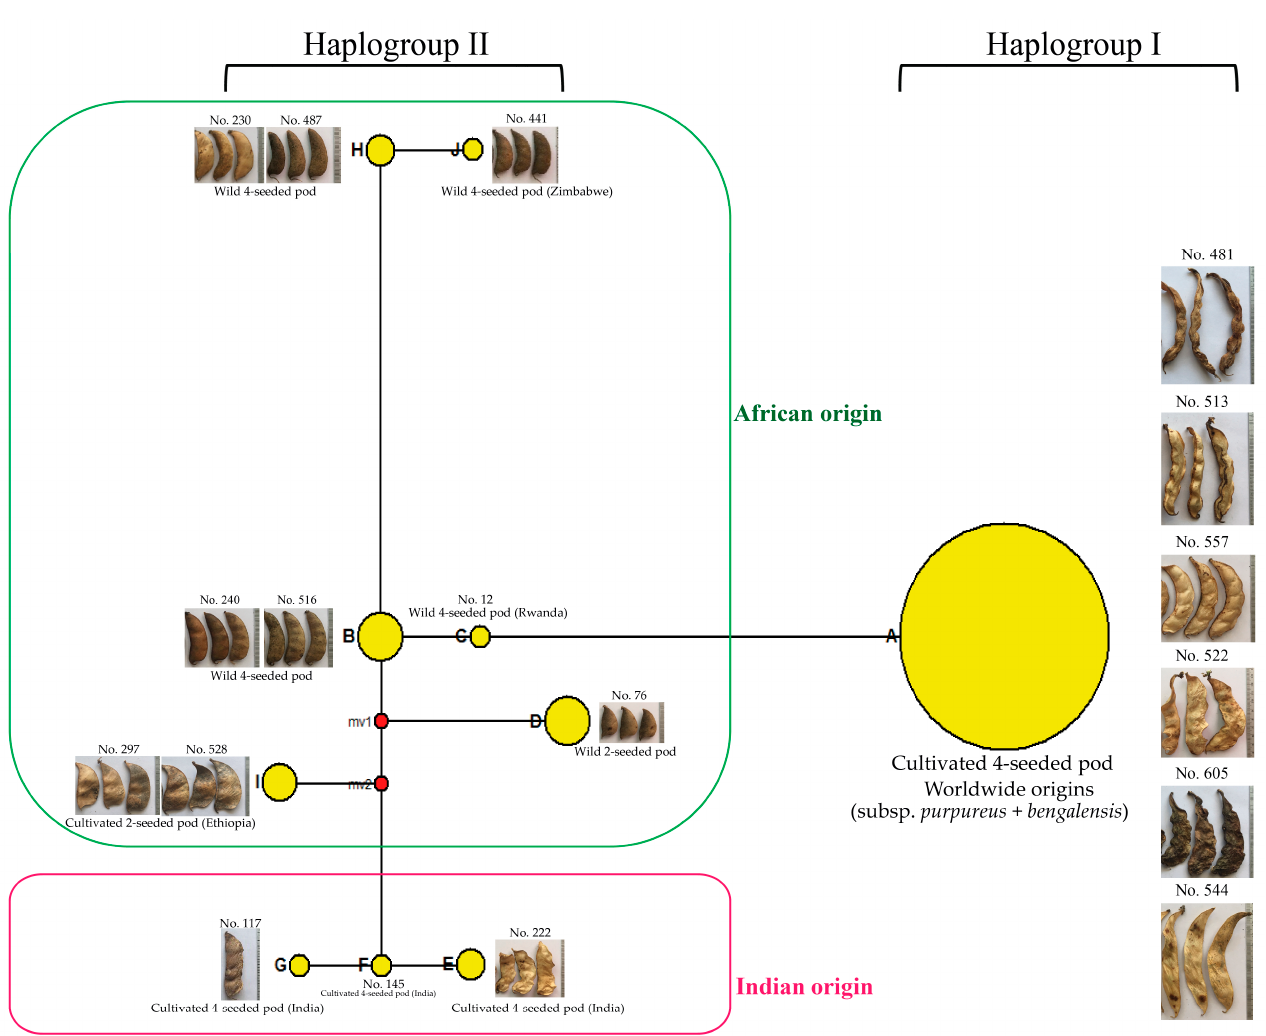
Figure 5. Scheme depicting haplotype network of 460 lablab accessions. Branch lengths is propor- tional to the number of mutational steps in 10 chloroplast haplotypes. Size of pie chart is propor- tional to the haplotype frequency. Mv1 and mv2 represent mean median vector.